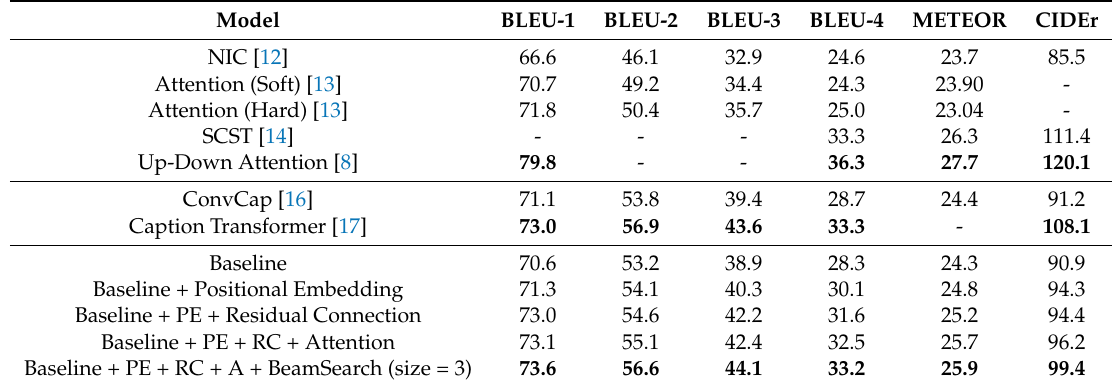
Table 1. The comparison of our model with other LSTM and non-LSTM models on the MSCOCO test dataset based on the Karpathy splitting method